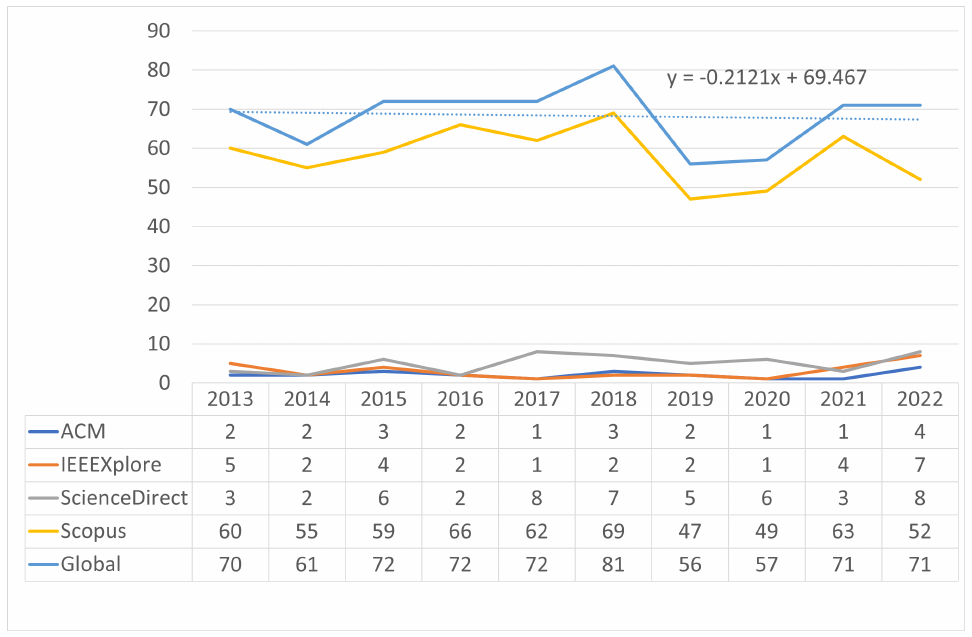
Figure 6. Trends of articles between years.